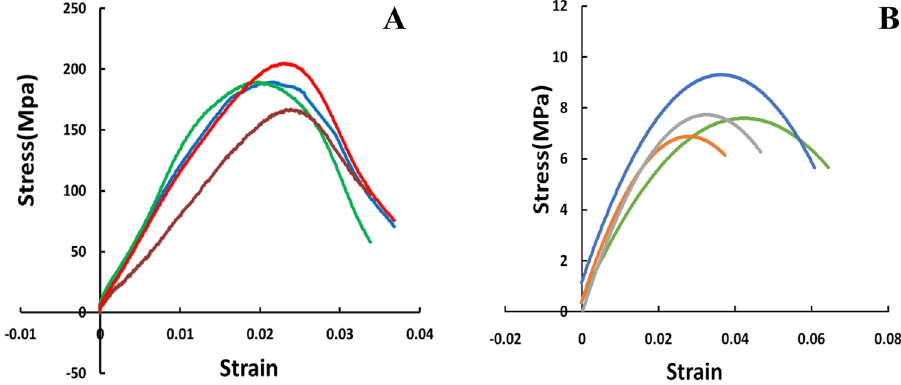
Figure 6. Dynamic stress-strain curve for rabbit femur bone tissue. ( A ) Cortical bone; ( B ) Cancellous